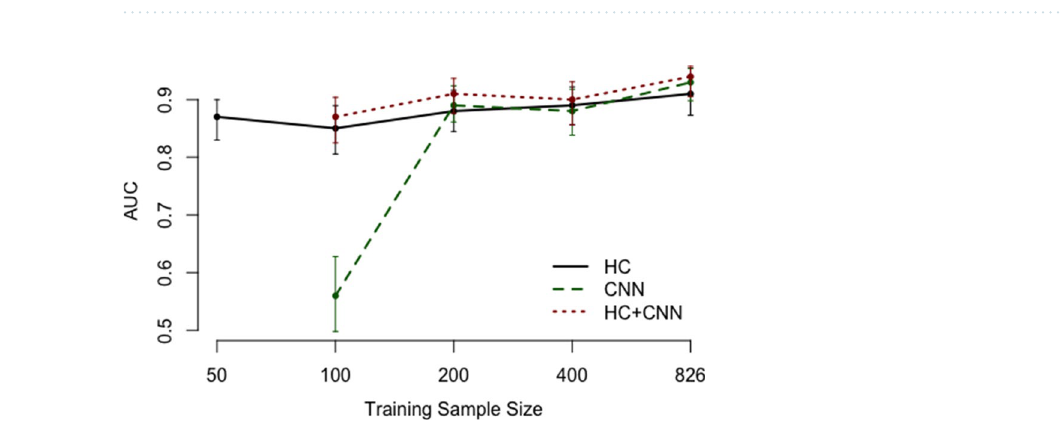
Table 1. AUC and specificity (with sensitivity = 0.95) of testing data for models with different combinations of features using RF with the complete training data.